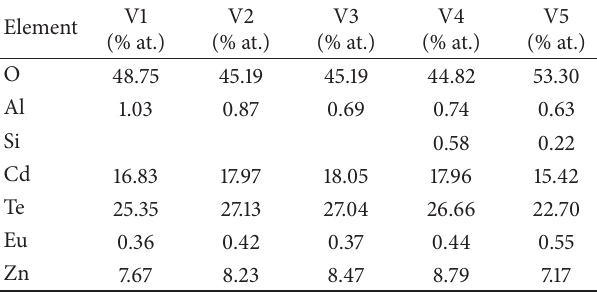
. Table 2: Final compositions for ZnO-CdO-TeO 2 mined by SEM/EDS